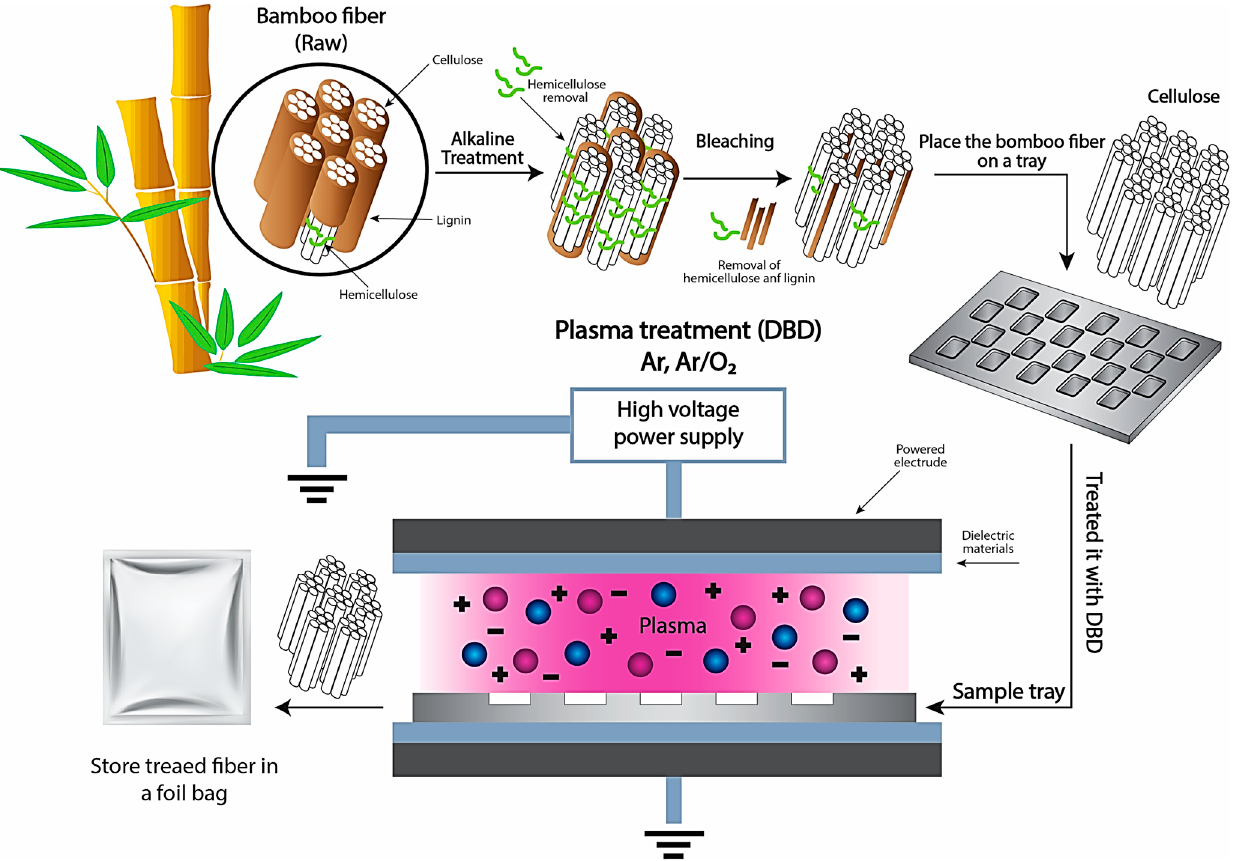
Figure 1. Schematic representation of the plasma treatment and diagram of atmospheric-pressure DBD plasma cell. Table 1. Plasma-treatment parameters for untreated and treated samples.